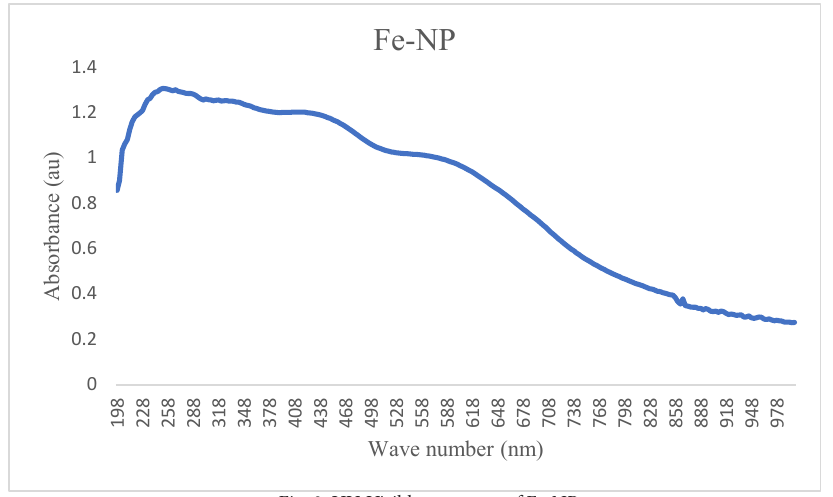
Figure 3: UV-Visible spectrum of Fe-NPs Fig. 3. UV-Visible spectrum of Fe-NPs.